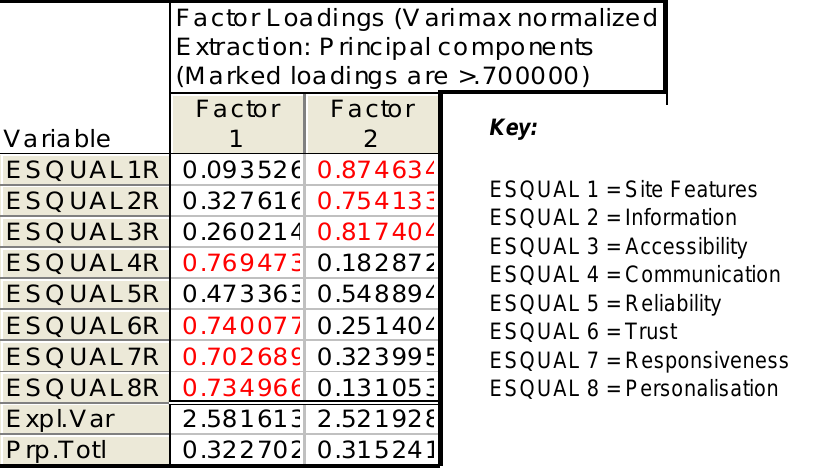
Latent factor one seems to encapsulate a high- technology orientation (which we have labeled „ techno-savvy ‟) , whilst latent factor two seems to encapsulate a more traditional mindset towards e-service quality (which we have labeled „ traditional ‟). To further analyse the e-service quality variables with regards to consumer preferences, age is added into a non- hierarchical cluster analysis in order to investigate whether age could be used as a significant demographic